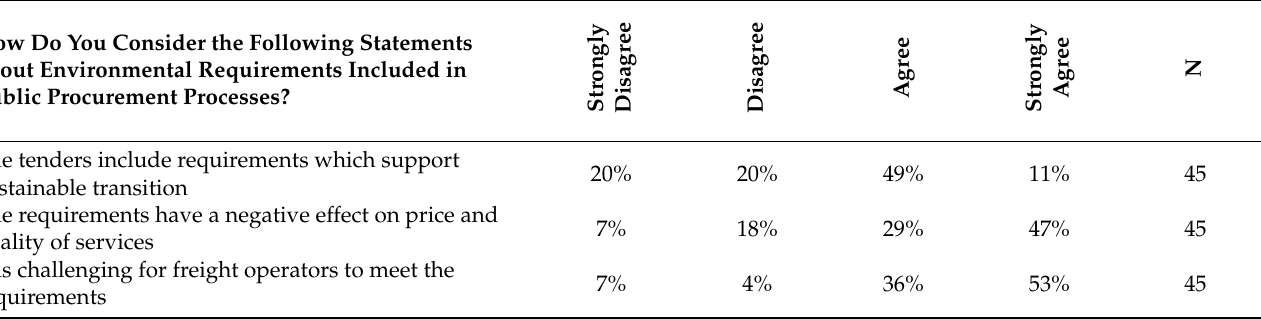
Table 12. FSP’s assessment of consequences of environmental requirements in public